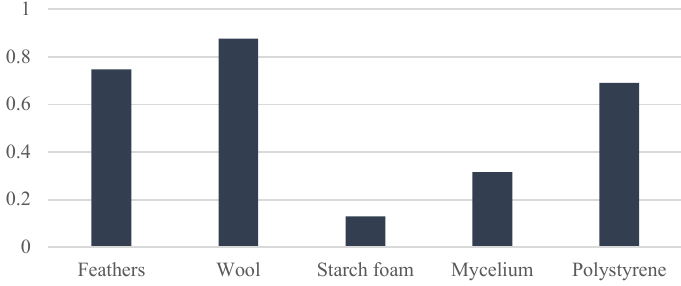
Fig. 3. Technique for Order of Preference by Similarity to Ideal Solution ranking of thermal packaging materials. Y axis represents the proximity to ideal solution 1. Among the thermal packaging options, the closest proximity to ideal solution (represented by 1 on Y axis in Fig. 3) by applying TOPSIS method was assigned to non-woven